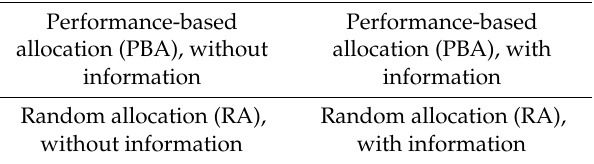
Table 1. Treatment overview (2 × 2